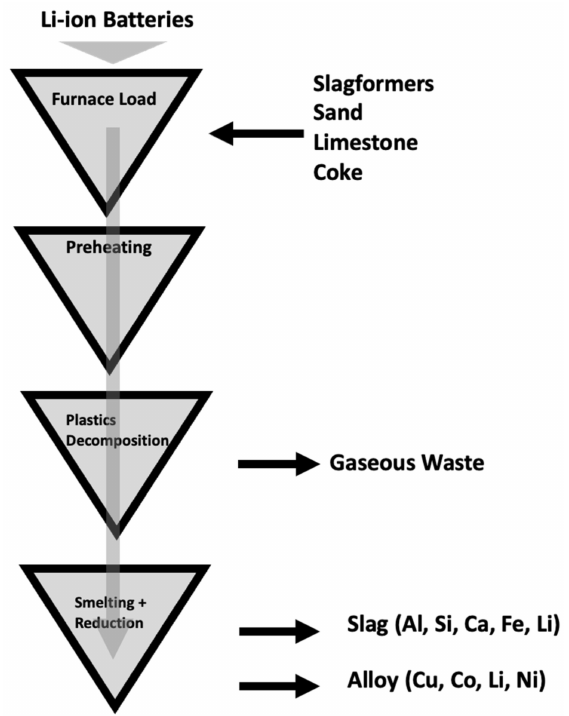
Figure 14. Process flow diagram for the Umicore process (Data derived from refs.